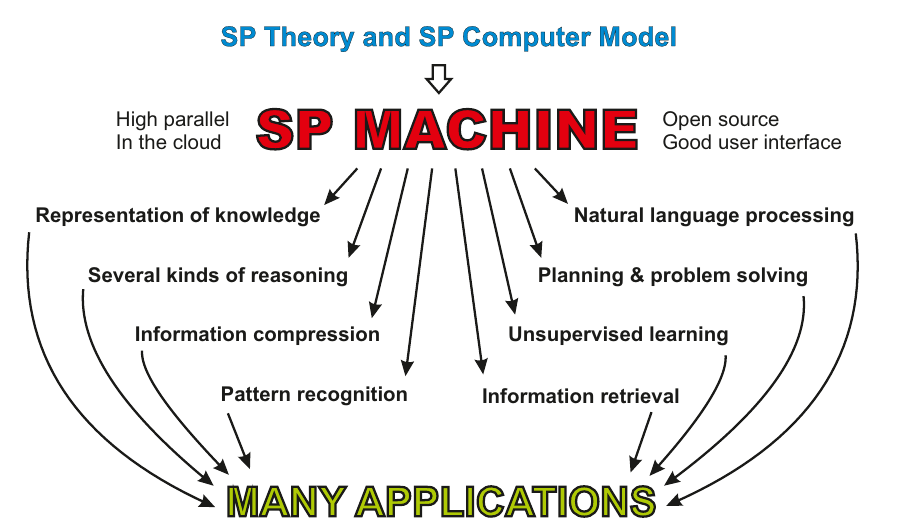
Figure A4. Schematic representation of the development and application of the SP Machine. Repro- duced from Figure 2 in [19], with